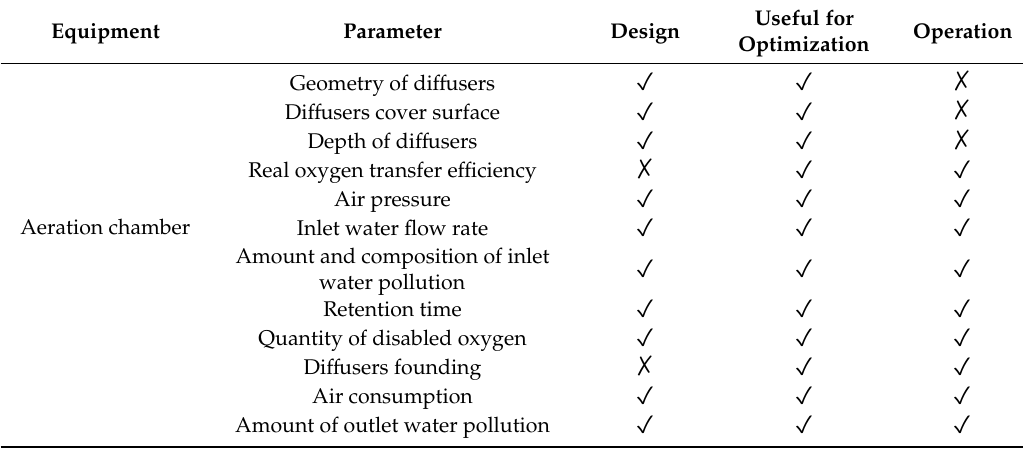
Table 4. Parameters of the aeration